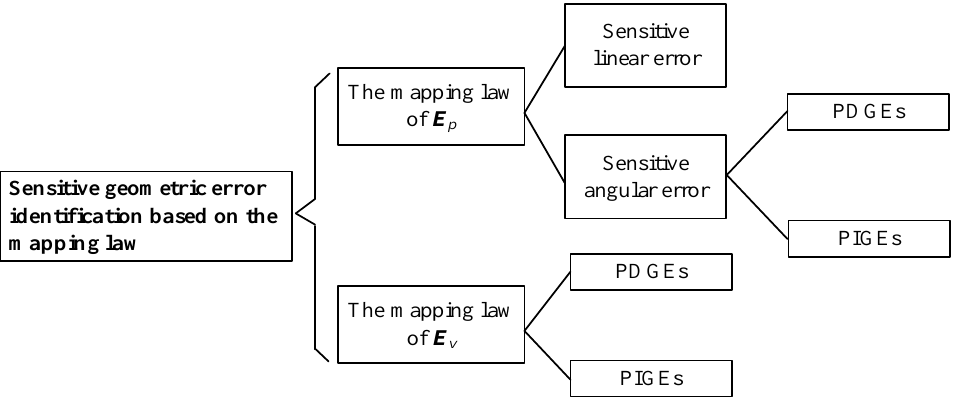
Figure 8. Sensitive geometric error identification process based on the proposed mapping law.